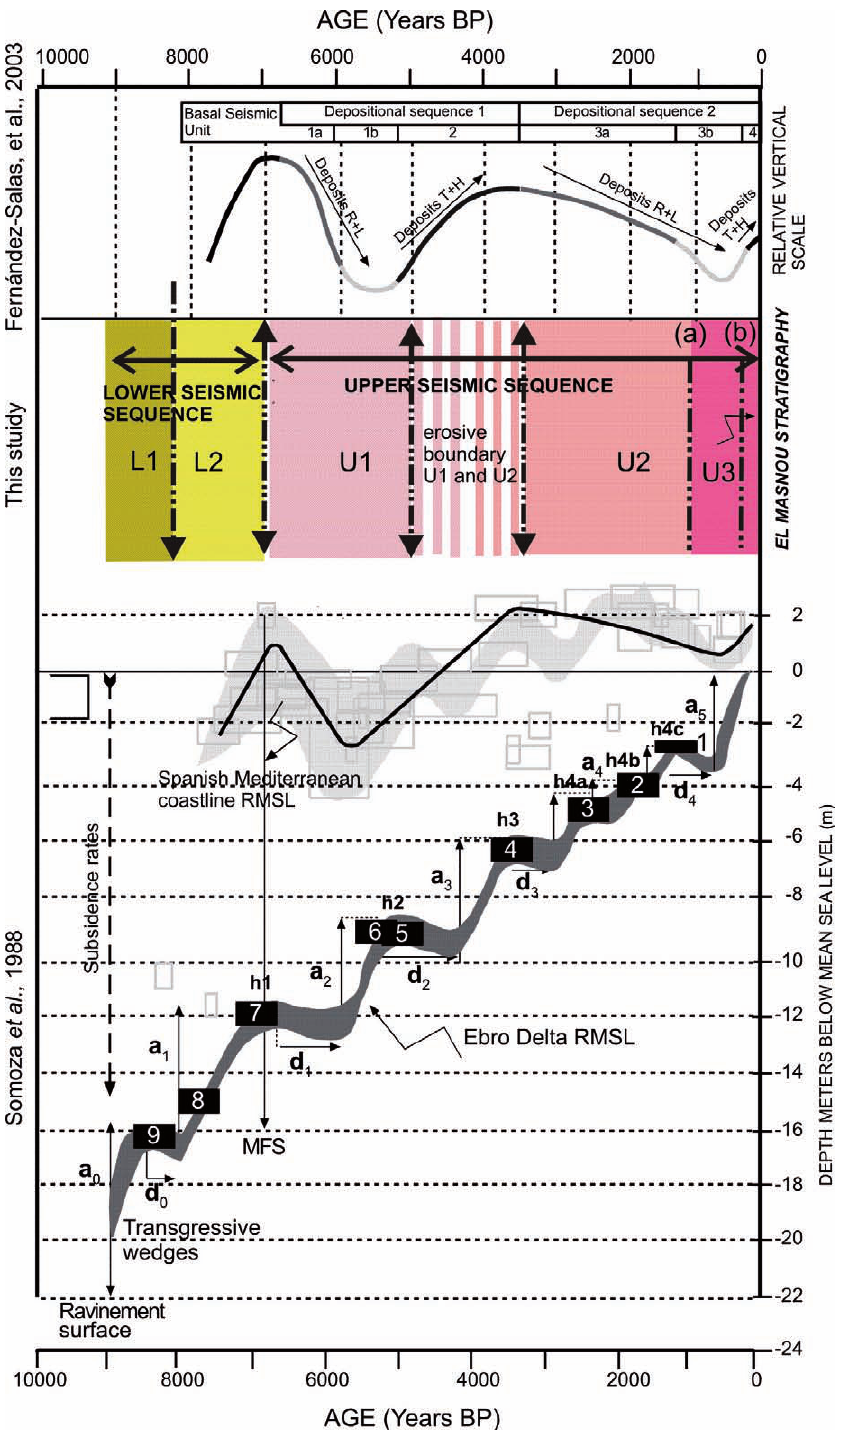
f ig . 8. – Theoretical correlations of our seismic and sequence stratigraphy with the stratigraphies and sea-level changes defined by Somoza et al. (1998) in the Ebro delta and by Fernández-Salas et al . (2003) in the south of the Iberian Peninsula. The comparative analysis indicates that units L1 and L2 would correspond to d and a , respectively of Somoza et al . (1998), and the combination of the two units to the Basal 0 1 Seismic Unit of Fernández-Salas et al . (2003). Unit U1 correlates with the combination of d , a , d and a of Somoza et al . (1998) and seismic 1 2 2 3 unit 1 within depositional sequence 1 of Fernández-Salas et al. (2003). The boundary between units U1 and U2 coincides with the eustatic maximum h described by Somoza et al . (1998). Unit U2 correlates with units d , a and d of Somoza et al . (1998) and with seismic unit 3 3 3 4 4 within depositional sequence 2 of Fernández-Salas et al . (2003). Based on the two given interpretations about its millennial or centennial scale, unit U3 may correlate respectively with the combination of units d and a of Somoza et al . (1998) or only with a ; likewise, it may correlate 4 5 5 with subunit 3b (millennial scale) or seismic unit 4 (centennial scale) within depositional sequence 2 of Fernández-Salas et al .